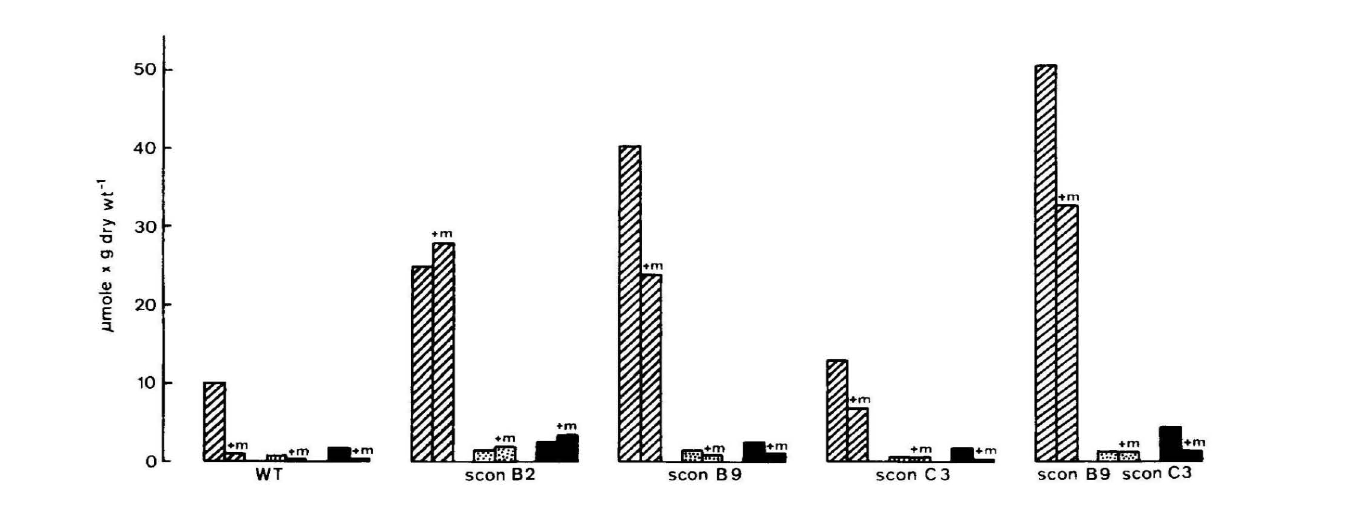
Figure I. Accumulation of "S-Iabelled methionine and homocysteine in mycelia of the 'COil and "ild type (WT) strains in the presence o[ "SO. -, and absence or presence (t- m) of 5 mM methionine. ~ total accumulation ("S retained on Dowex 50 (H t )). ['j homocysteine, • methionine. Mycelia were grown in the presence of methionine tor 6 h. then Na2"S04 (4X 10' cpm/mmol) was added for next 12 h. Detennination of methionine and homocysteine in mycelial extracts is described in Materials and